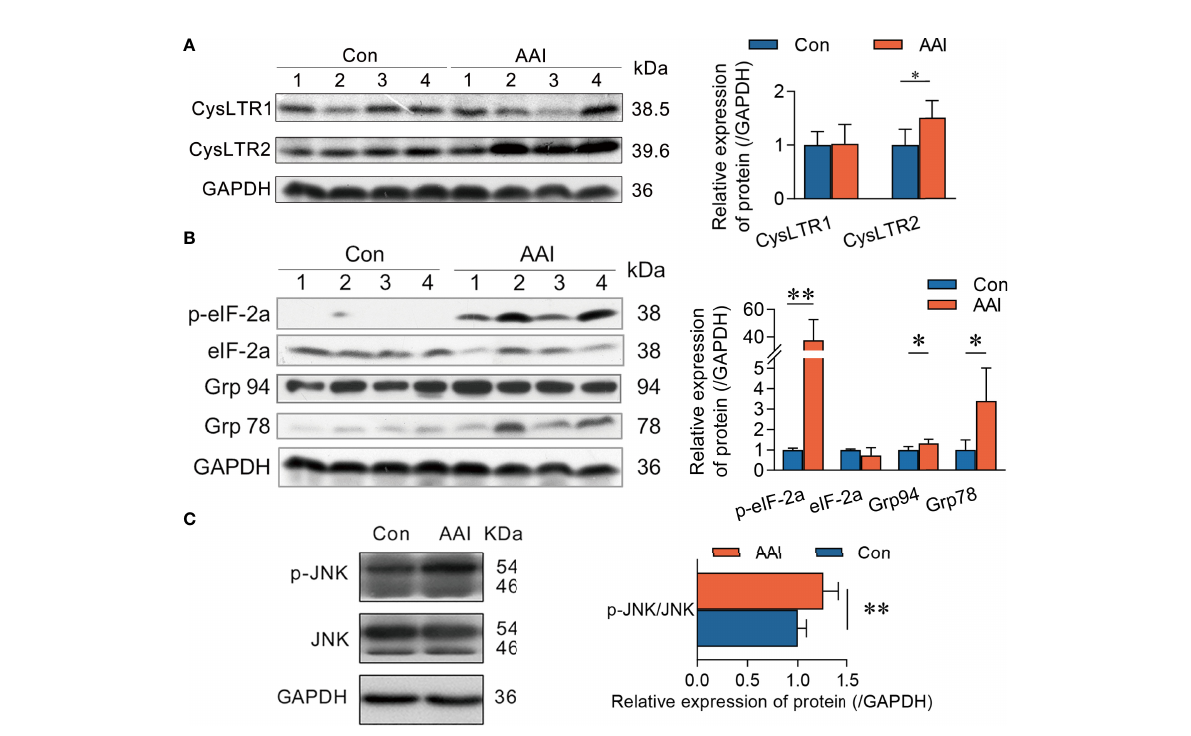
FIGURE 6 CysLTR2 overexpression along with ER stress and JNK phosphorylation in AAI-treated livers of canines. Liver tissues were obtained from canines after treatment with AAI (3 mg/kg/day) or fi ller only (negative control, Con) for 10 days. Immunoblot analyses of (A) CysLTRs, (B) molecular events for ER stress, and (C) phosphorylated JNK. GAPDH was used as loading control. Error bars represent the mean value ± SD. Student unpaired t- test was used to compare groups, and p- value less than 0.05 was considered as statistically signi fi cant. * p < 0.05 vs. control. ** p < 0.01 vs. control. For each analysis, n = 4/per